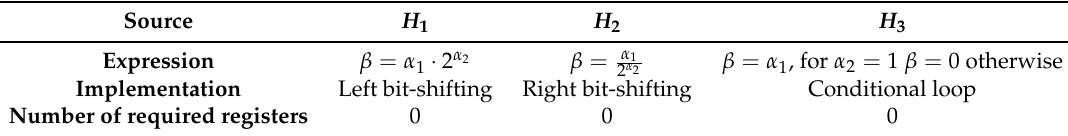
Table 1. Expressions of the transfer functions from Figure